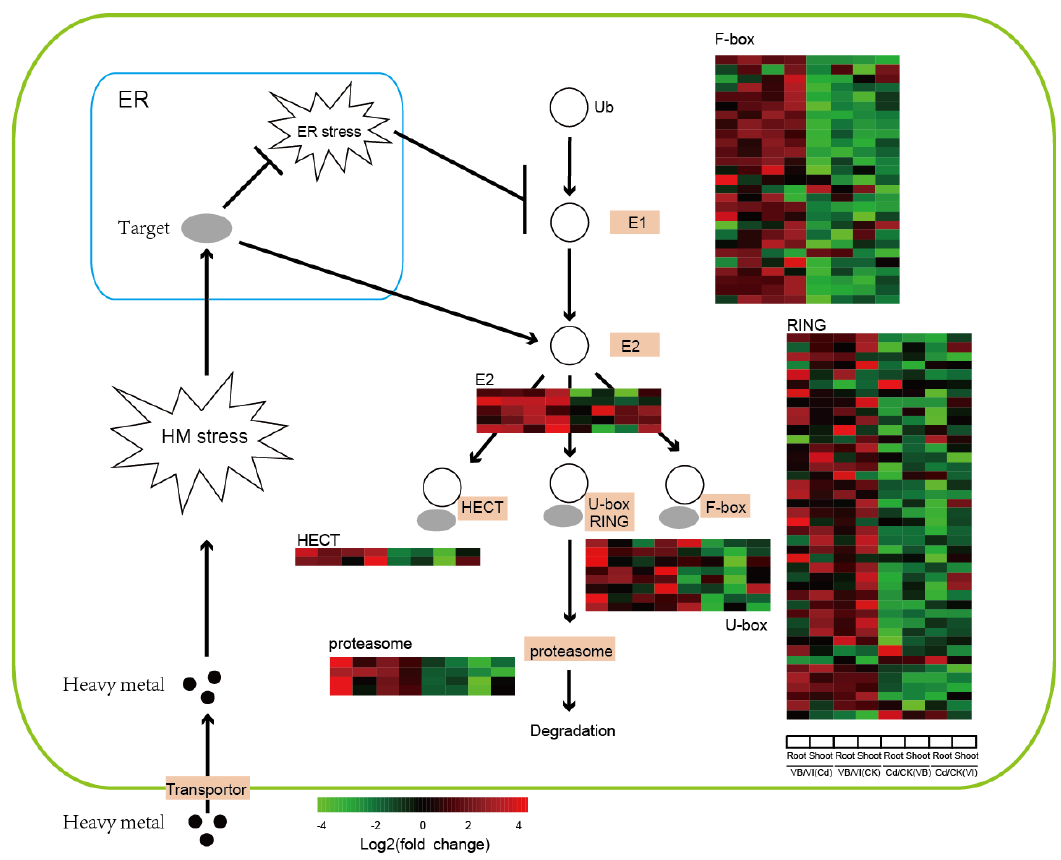
Figure 4. DEGs involved in the ubiquitin proteasome system (UPS) pathway with constitutively higher transcription levels in Viola baoshanensis . The heat maps for the relative transcription of DEGs were calculated by log2-fold changes. VB / VI(Cd), VB / VI(CK), Cd / CK(VB), and Cd / CK(VI) represent ratios of transcription levels between V. baoshanensis (VB) and V. inconspicua (VI) in the Cd treatment (Cd) and control (CK), and ratios of transcription levels of Cd / CK in VB and VI, respectively. E1, Ubiquitin-activating enzymes; E2, ubiquitin conjugases; HECT, U-box, F-box and RING, subfamilies of ubiquitin ligases. See more details about activation of the UPS pathway by ER stress in Table S11, Sections 2.4 and 3.1 (under the